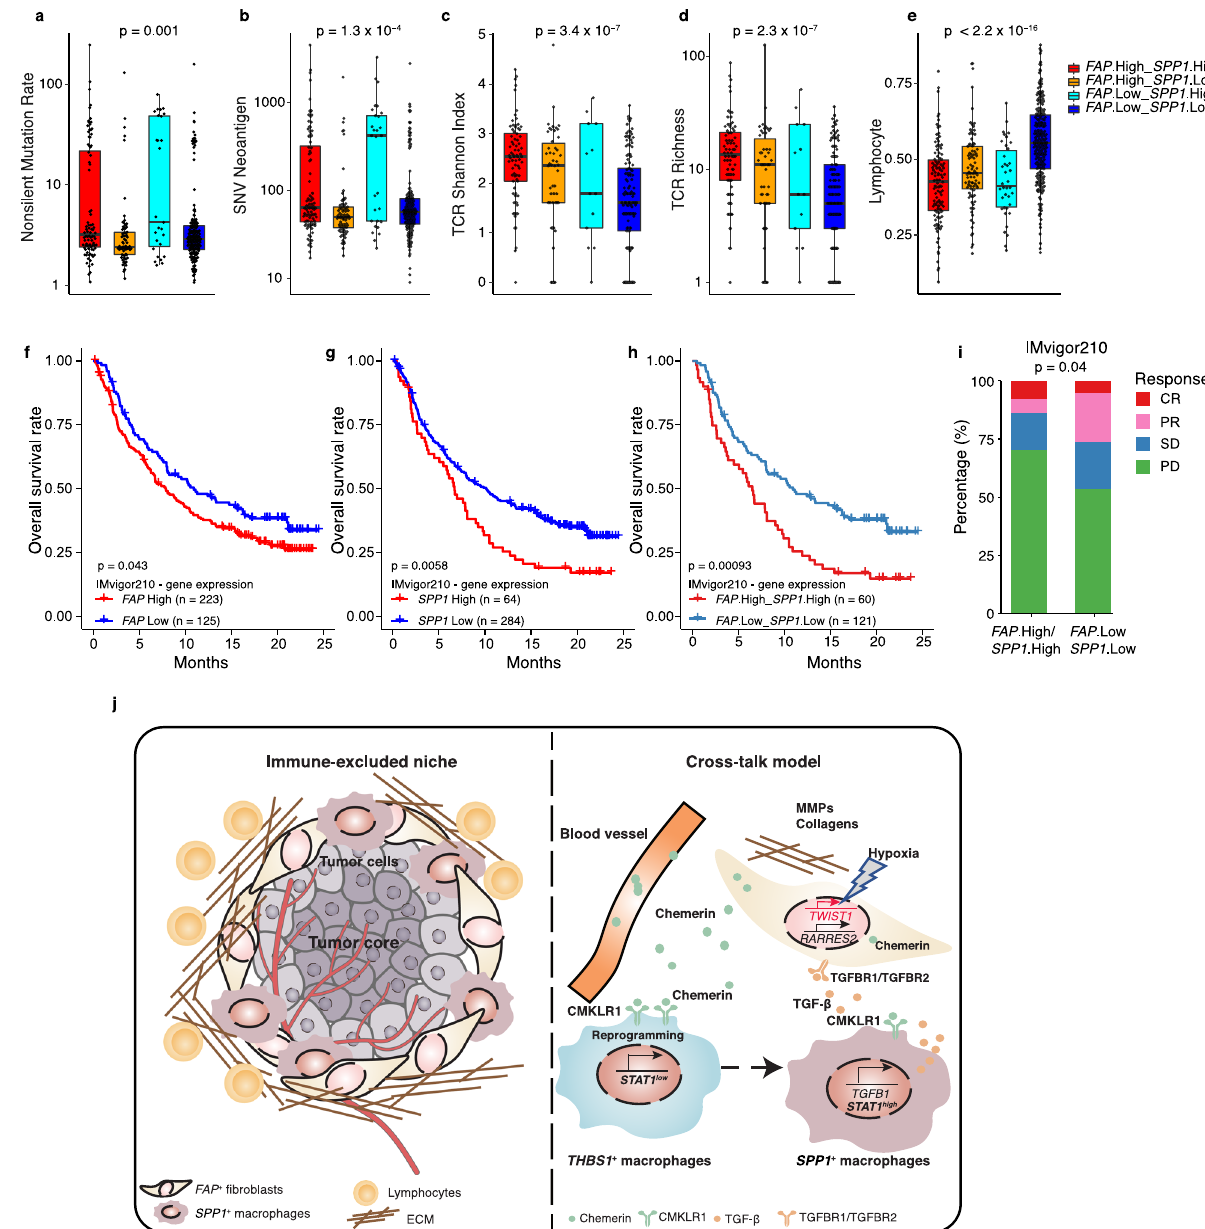
Fig. 8 The in fi ltration of lymphocytes in TME and response to PD-L1 blockade in patients affected by SPP1 + macrophages and FAP + fi broblasts. a – i The non-silent mutation rate ( a ), SNV neoantigen ( b ), TCR Shannon index ( c ), TCR richness ( d ), and the in fi ltration of lymphocyte ( e ) for four subgroups of TCGA-COAD patients strati fi ed by the in fi ltration of both FAP + fi broblasts and SPP1 + macrophages, including FAP + High_ SPP1 + High ( n = 113), FAP + High_ SPP1 + Low ( n = 87), FAP + Low_ SPP1 + High ( n = 41), and FAP + Low_ SPP1 + Low ( n = 225) The boxes show the median ± 1 quartile, with the whiskers extending from the hinge to the smallest or largest value within 1.5× the IQR from the box boundaries. f – h Survival analyses for low and high expression of FAP alone ( f ), SPP1 alone ( g ), and both ( h ) patient groups in the anti-PD-L1 immunotherapy cohort using Kaplan – Meier curves (IMvigor210 cohort). i Bar plots show patients with both low expression of FAP and SPP1 are more likely to respond to anti-PD-L1 treatment. j Working model for the immune-excluded niche and crosstalk model between FAP + fi broblasts and SPP1 + macrophages. CRC, colorectal cancer; TCGA, The Cancer Genomic Atlas; COAD, colon adenocarcinoma; GSEA, gene set enrichment analysis; IF, immuno fl uorescence; TCR, T-cell receptor; SNV, single-nucleotide variant; IQR, interquartile range; CR, complete response; PR, partial response; SD, stable disease; PD, progressive disease. One-way ANOVA test was used in ( a – e ). A two-sided log-rank test was used to assess statistical signi fi cance in ( f – h ). Fisher ’ s test was used in ( i ). Source data are provided as a Source data Fig. 8a – pseudocount.use = F, only.pos = T. The scaled expression of regulon activity was www. fi serlab.org/tf2dna_db/). We overlapped the TF genes with the DEGs quanti fi ed used to generate a heatmap. above, and determined the most speci fi cally expressed TFs in each cluster. To check the gene expression of transcription factors (TFs) alone, we retrieved Genes encoding TFs from four TF-related public datasets: JASPAR 87 (http:// jaspar.genereg.net/), DBD 88 (http://www.transcriptionfactor.org/), AnimalTFDB 89 Characterization of cell-type in fi ltration based on single-cell expression (http://bioinfo.life.hust.edu.cn/AnimalTFDB/), and TF2DNA 90 (http:// matrix . To establish the proportions of our de fi ned 9 major cell types and